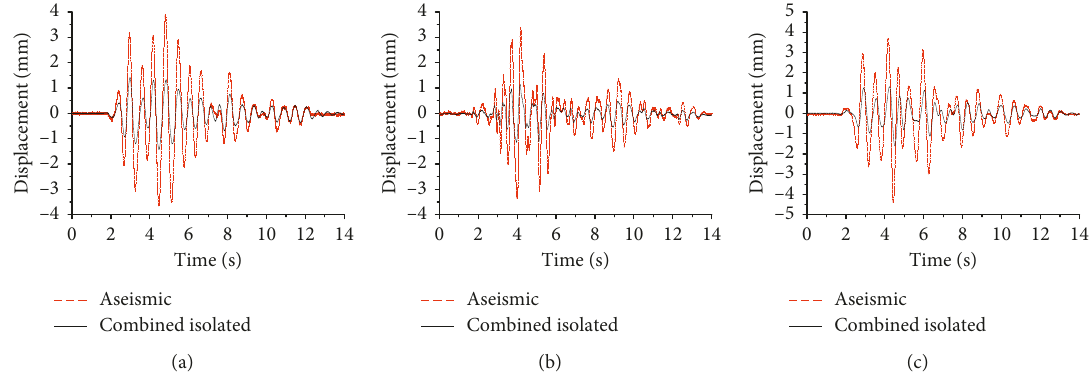
Figure 6: Y -axis relative displacement time history curves of the top floor of the third subframe. (a) Chi-Chi-2N, (b) Chi-Chi-2F, and (c)